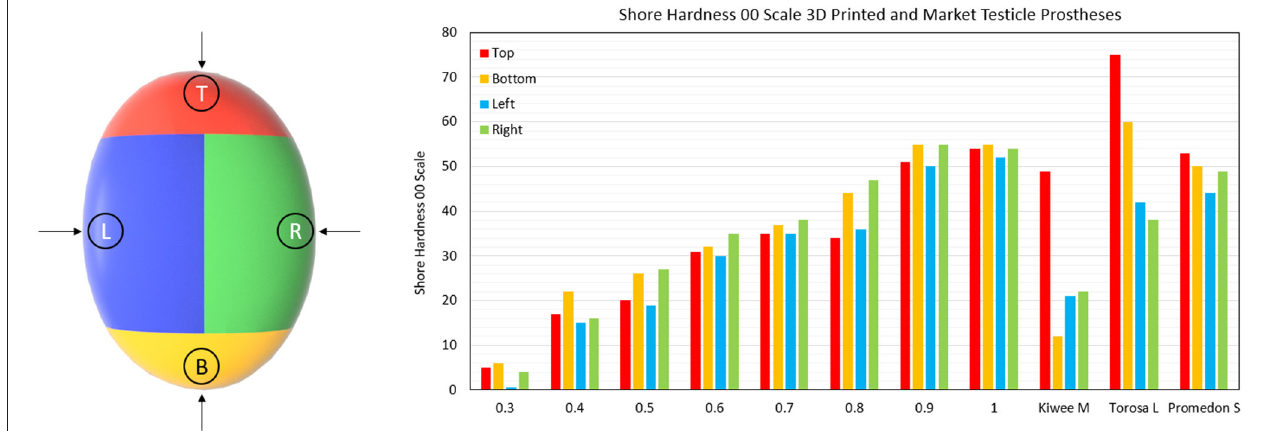
FIGURE 5 | Shore Hardness OO scale results for 3D printed testicles and medical prostheses. Notably the Kiwee which is a silicone coated silicone gel filled prostheses shows appropriate hardness results (within ranges of relative density 0.3–0.4); however, Torosa and Promedon prostheses are relatively hard compared to natural tissue. Note that the Hardness results for Torosa small and medium sized prostheses are the same as the large size, as the hardness value is dominated by the material and not minor changes in